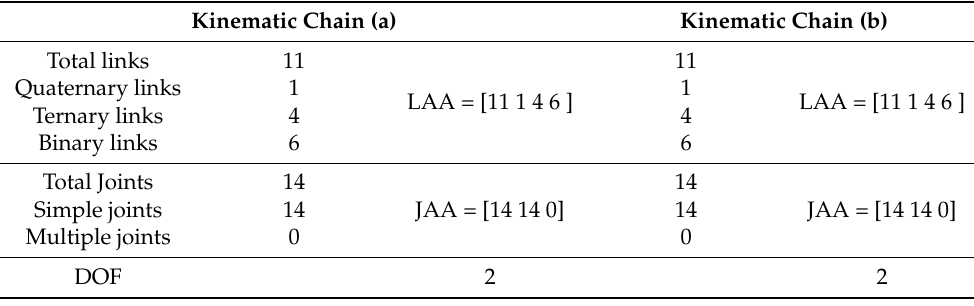
Table 2. Link Assortment Array and Joint Assortment Array for kinematic chains in Figure 9.